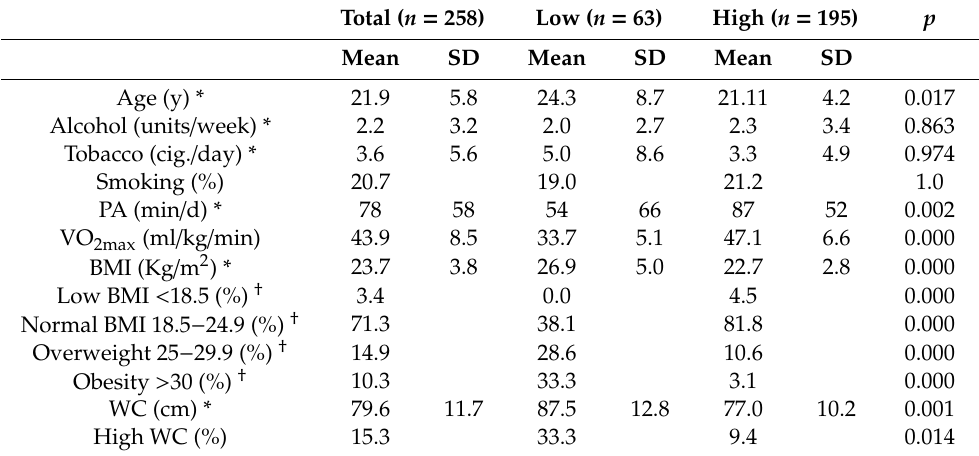
Table 3. Characteristics of the participants according to VO 2max (low and